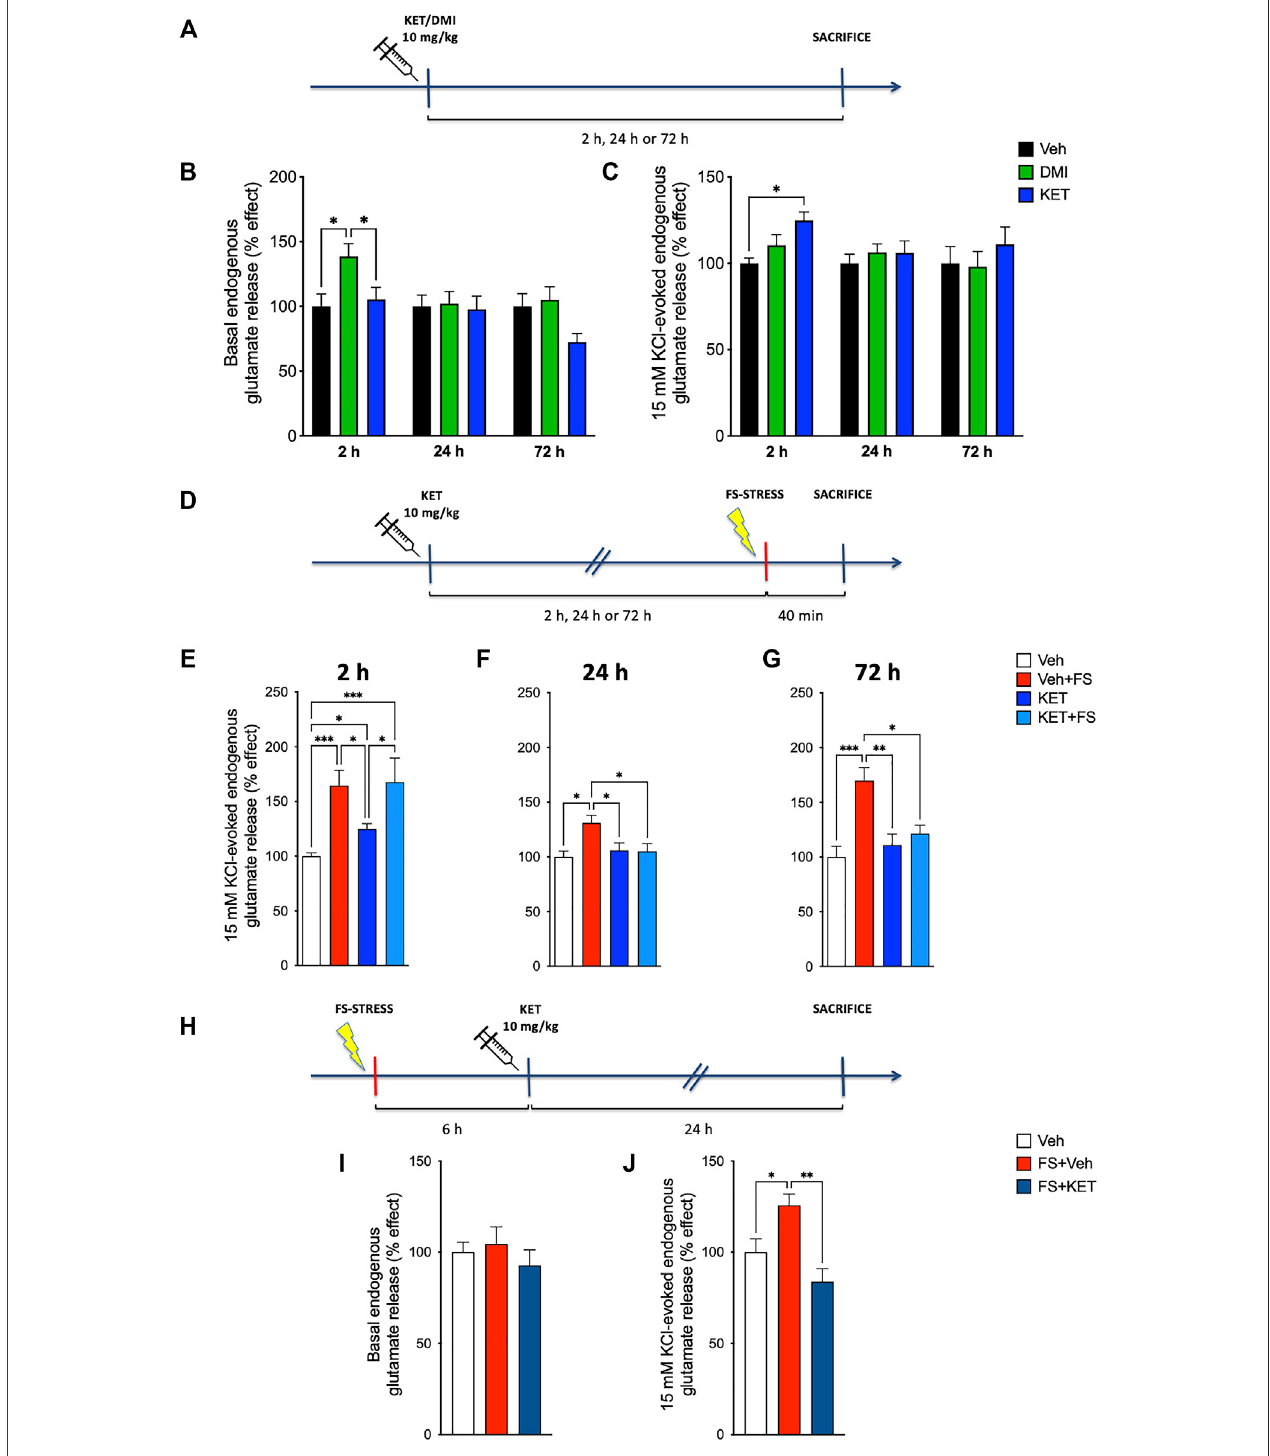
FIGURE 1 | Endogenous glutamate release: (A) experimental plan timeline for panels (B) and (C) . Rats were injected with saline (vehicle, Veh), ketamine (KET, 10 mg/kg), or desipramine (DMI, 10 mg/kg) and sacri fi ced 2, 24, or 72 h after. Time-course of changes in basal (B) and 15 mM KCl-evoked (C) endogenous glutamate releasefromprefrontalcortex(PFC)-puri fi edsynaptosomesinsuperfusion.Thenetdepolarization-evokedover fl owwascalculatedbysubtractingthetransmittercontent of the basal out fl ow. Data are expressed as percent change means ± standard error of the mean (S.E.M.) vs. Veh. Two-way analysis of variance (ANOVA), Bonferroni post-hoc test. * p < 0.05. (D) Experimental plan timeline for panels (E – G) . Rats were injected with saline (Veh), injected with saline and subjected to